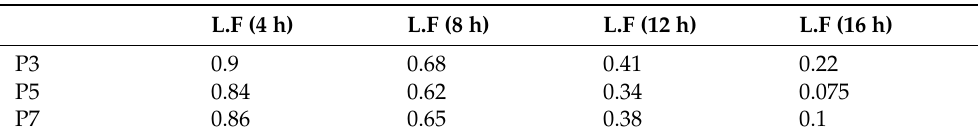
Table 4. The PCM liquid-fraction progression for three different HTF-tube arrangements of P3, P5, and P7 over multiple solidification